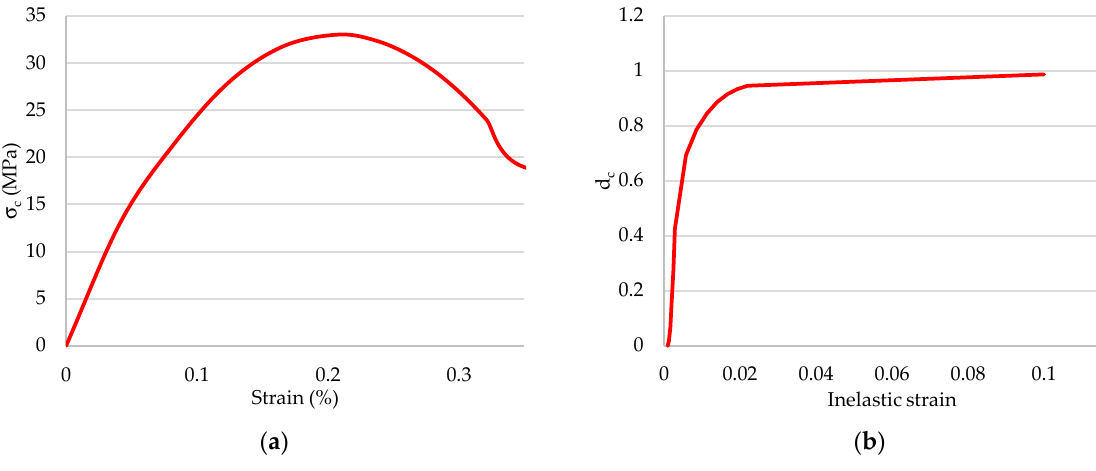
Figure 12. Parameters of concrete in compression: ( a ) stress–strain relation of concrete for structural analysis based on EN 1992-1-1; ( b ) concrete stiffness degradation in compression.